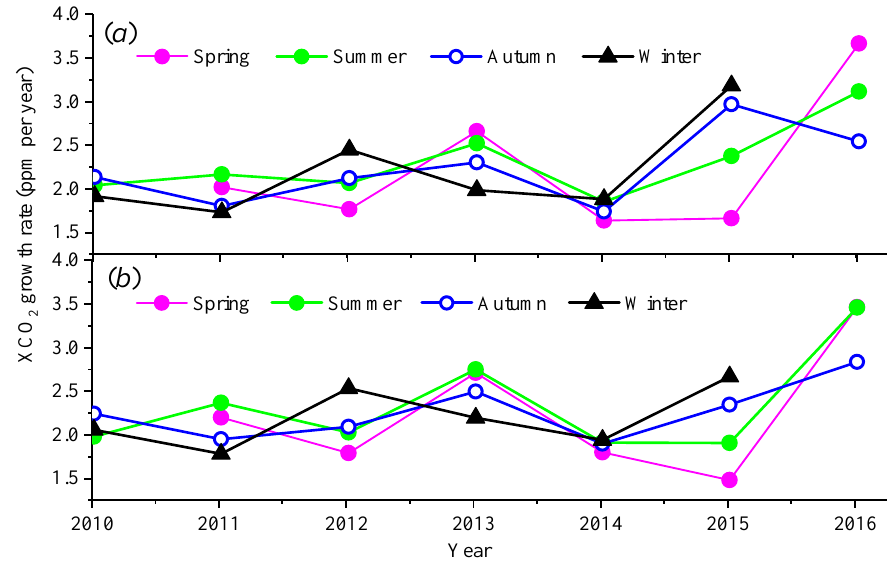
Figure 17. Plots of the global seasonal mean XCO 2 growth rates inferred from ( a ) the merged satellite data and ( b ) the CT2017